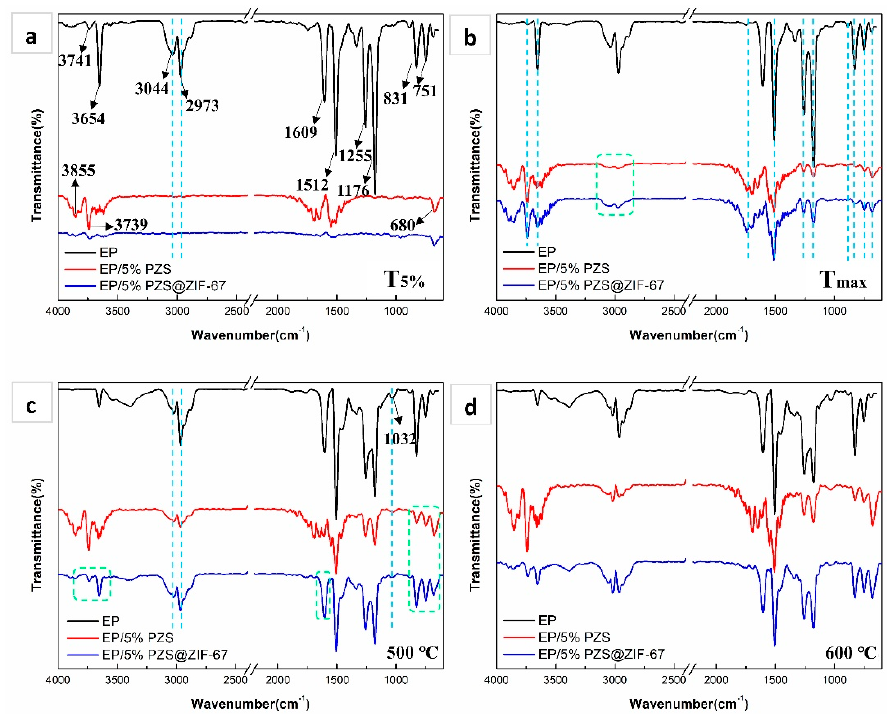
Figure 11. FTIR spectra of the gaseous products of the EP, EP/5% PZS, and EP/5% PZS@ZIF-67 at T 5% ( a ), T max ( b ), 500 °C ( c ), and 600 °C ( d ).